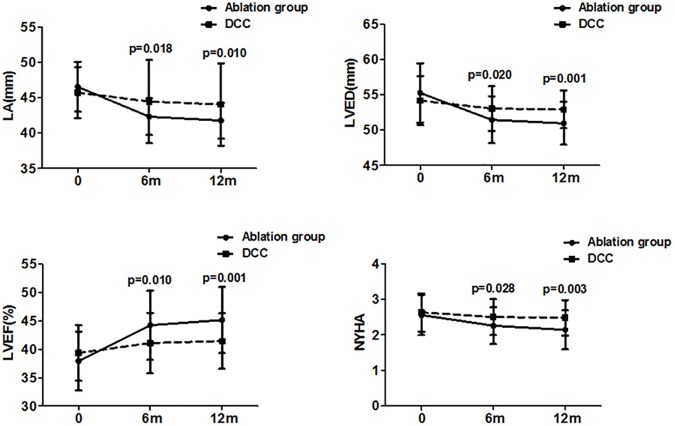
Comparisons of LA, LVEDD, LVEF and NYHA at 6 and 12 months between study groups.LA, left atrial; LVED, left ventricular end-diastolic; LVEF, left ventricular ejection fraction; AF, atrial fibrillation; NYHA, New York Heart Association.